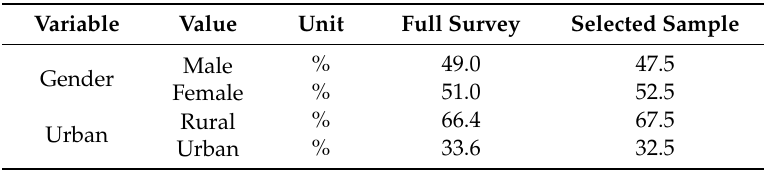
Table 1. Sample distribution of participants.